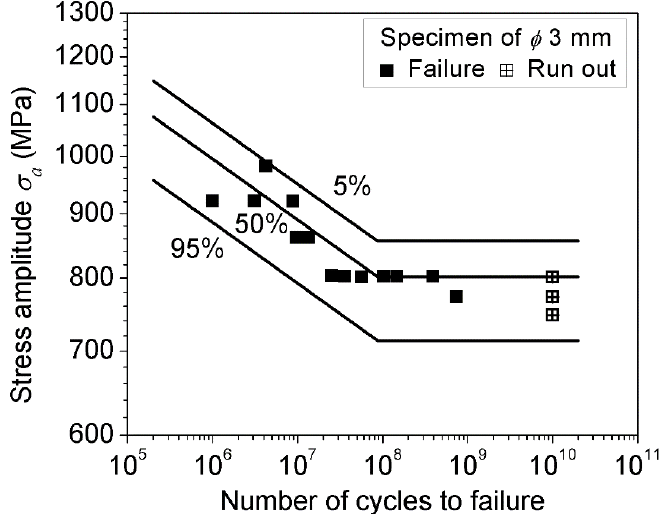
Figure 8. Comparison of predicted P-S-N curves with experimental data for a high strength steel JIS-SCM440 in literature [23].